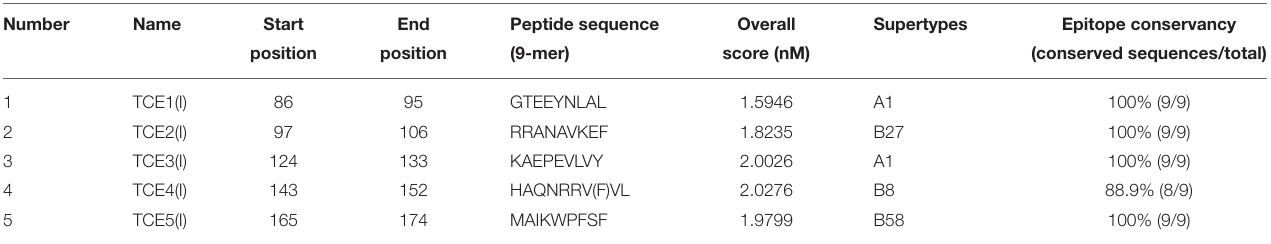
TABLE 6 | The selected best five potential epitopes of the OmpA protein of Anaplasma marginale binding to MHC class I alleles, on the basis of their overall score predicted by the NetCTL server, and epitope conservancy result. Number